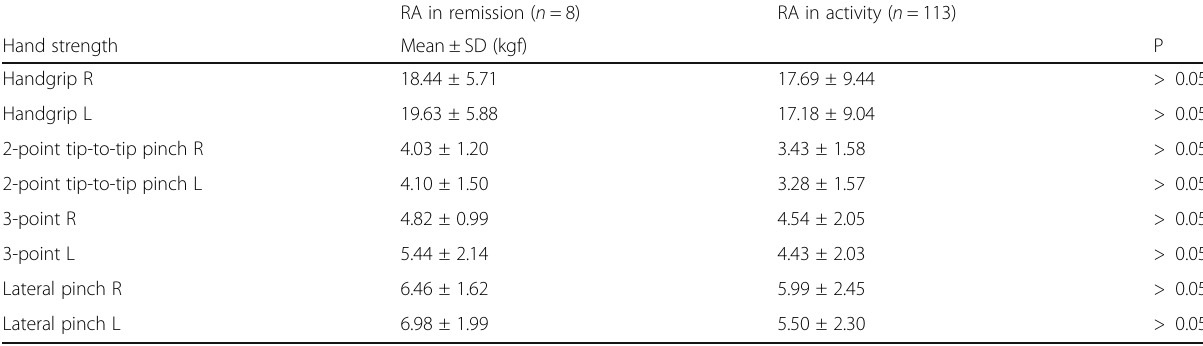
Table 6 Hand strength of patients with rheumatoid arthritis (RA) and Boolean remission or active disease RA in remission ( n = 8) RA in activity ( n = 113) Hand strength Mean ± SD (kgf) P Handgrip